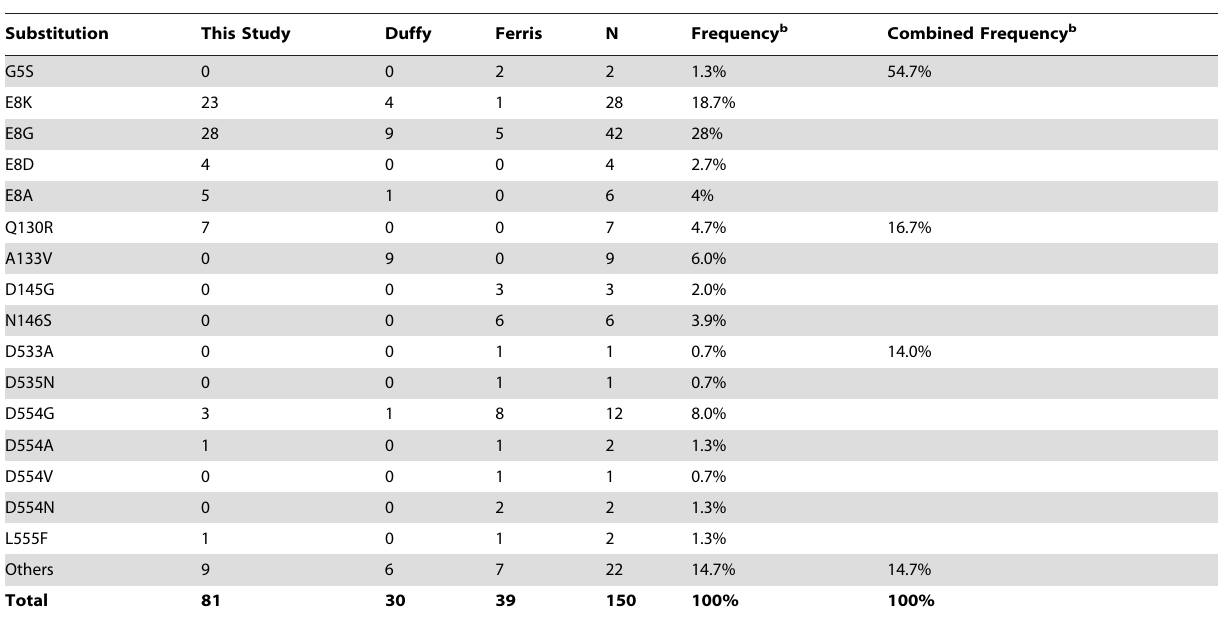
Table 2. Host Range Substitution Hotspots in Q 6 P3 Protein a .